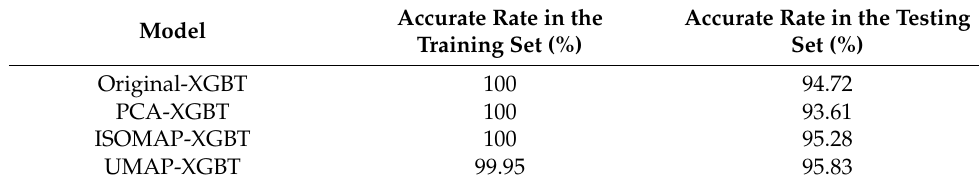
Table 4. The classification results in the training set and testing set based on XGBT.